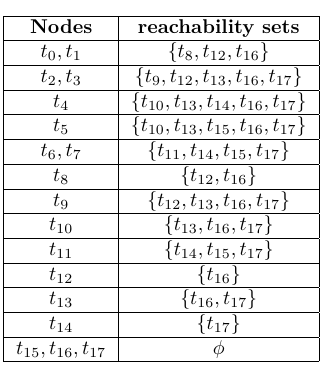
Table 7: The reachability